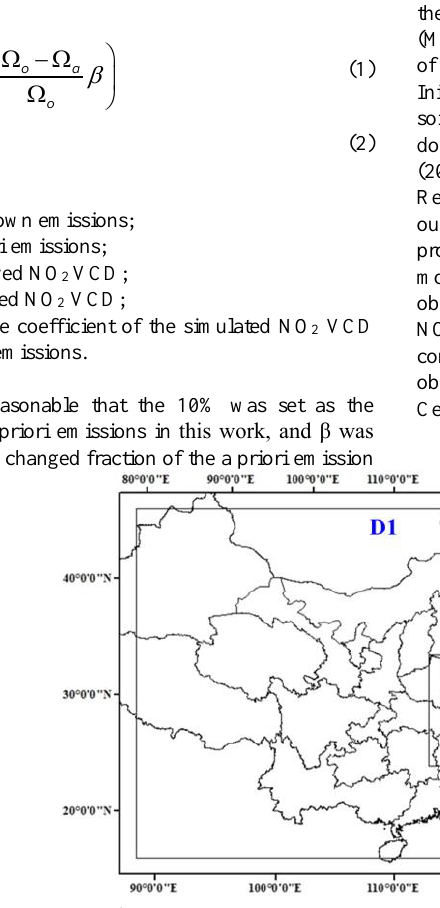
Figure 1. Model domain (AH, JS, ZJ and SH indicate Anhui, Jiangsu and Zhejiang provinces and Shanghai